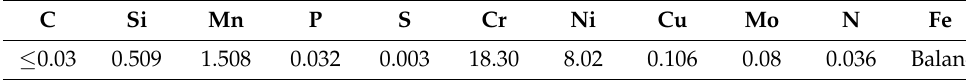
Table 1. Ta chemical composition table (wt.).